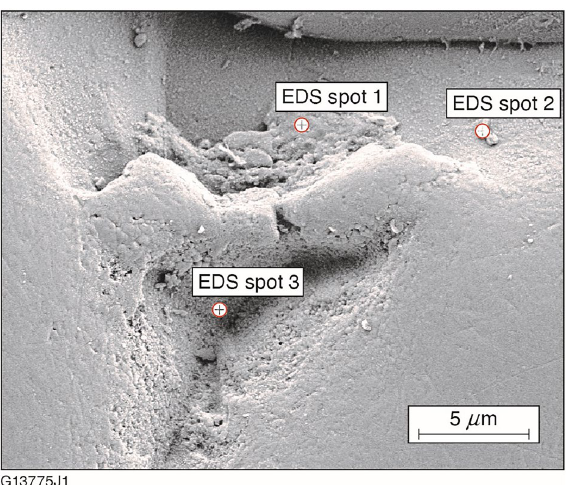
Figure 5. SEM image of the fracture pit and locations used to conduct EDS